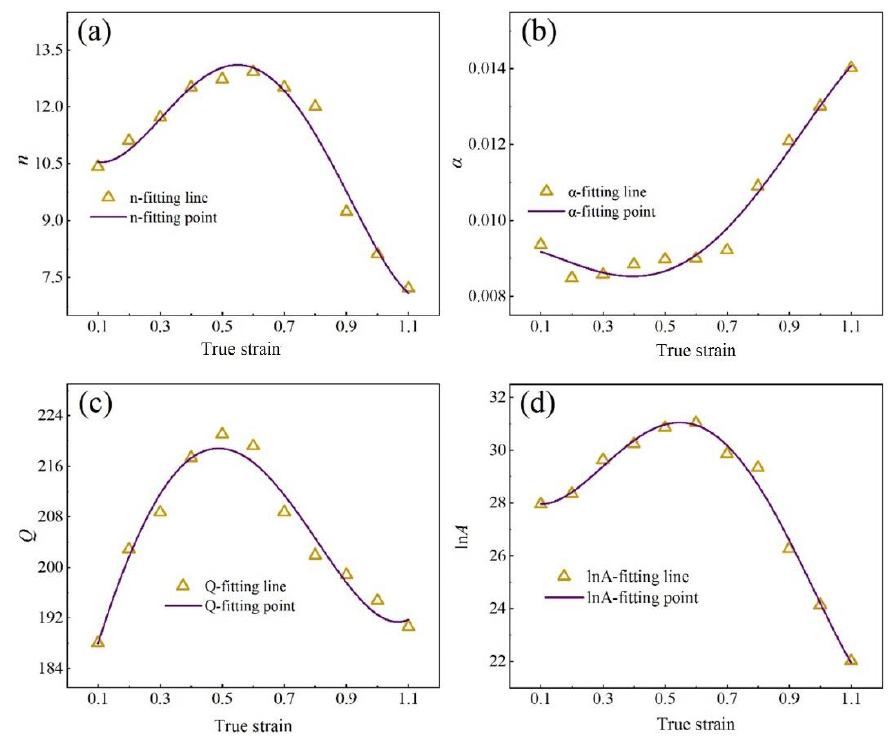
Figure 6. The relationship between ( a ) n , ( b ) α , ( c ) Q , ( d ) ln A and ε of Al-Zn-Mg-Cu alloy. Metals 2022 , 12 , x FOR PEER REVIEW